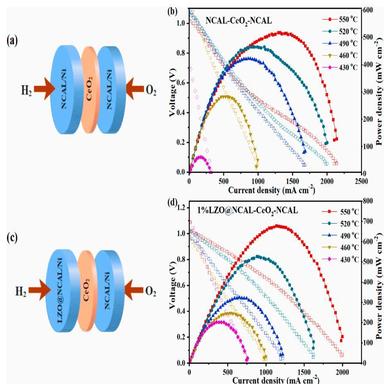
The schematic of fuel cell structure (a) NCAL/CeO2/NCAL; (c) LZO@NCAL/CeO2/NCAL; I–V–P characteristics of (b) NCAL/CeO2/NCAL, (d) LZO@NCAL/ CeO2/NCAL fuel cells tested at different temperatures.